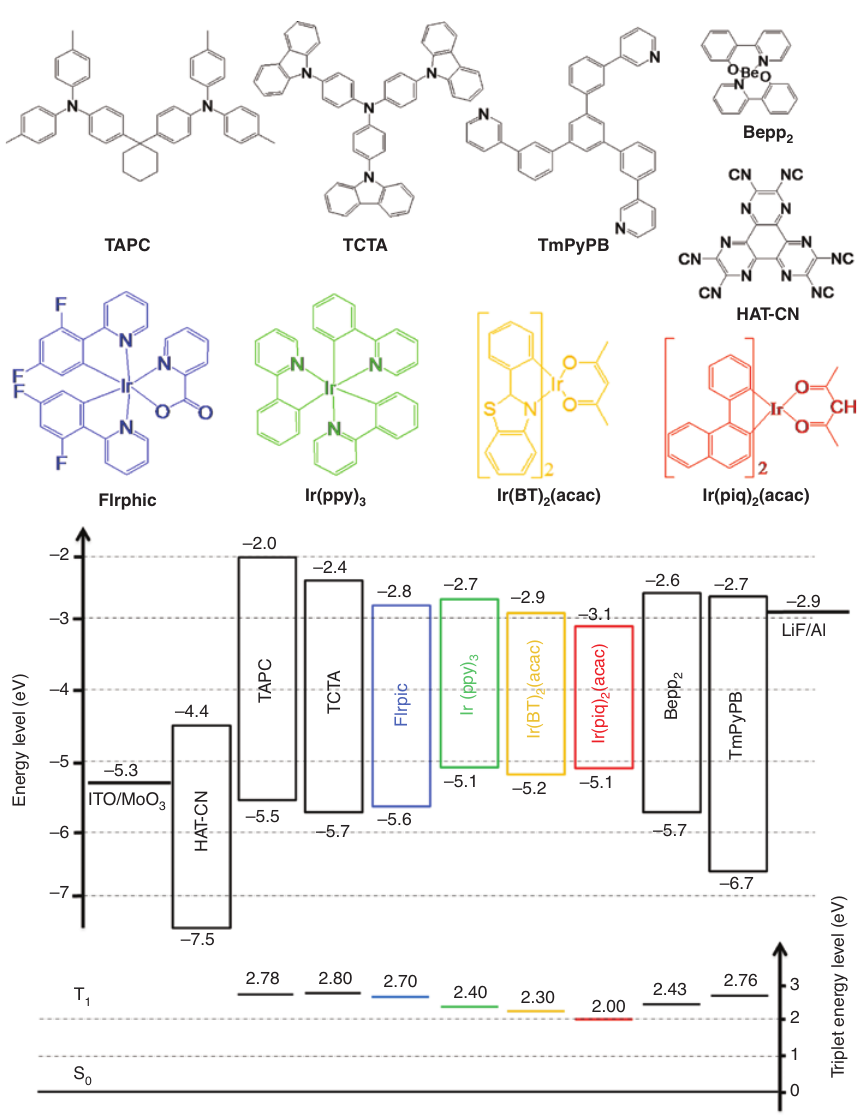
Figure 1: The chemical structure of organic materials and energy levels of all materials involved in this